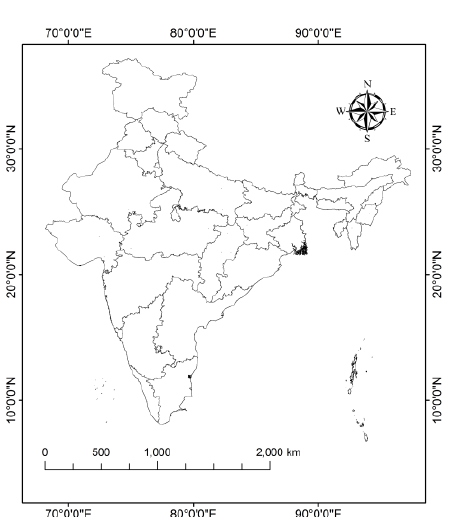
Figure 1. Geo-Political Boundary of India, the Study